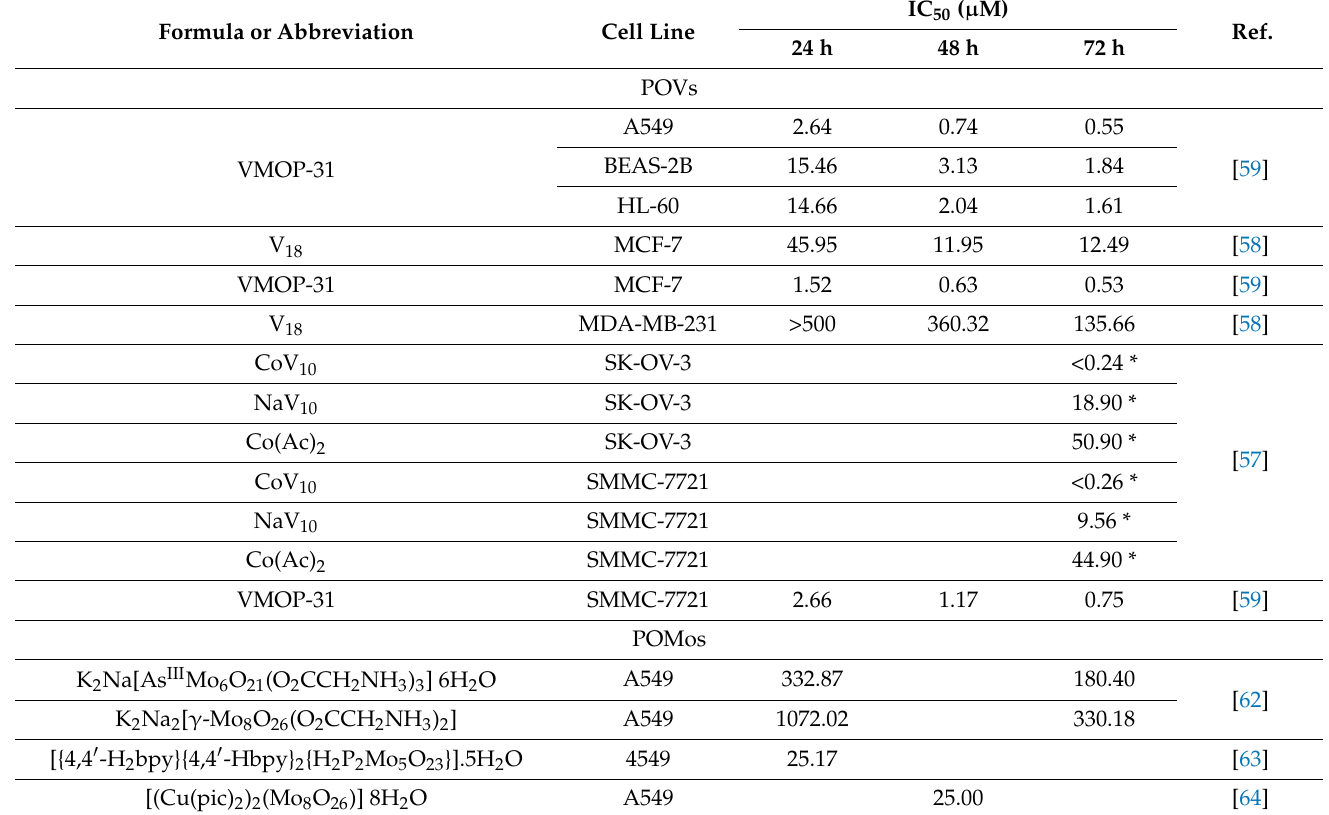
Table 2. IC 50 values ( µ M) of the different POMs studied in the respective cell